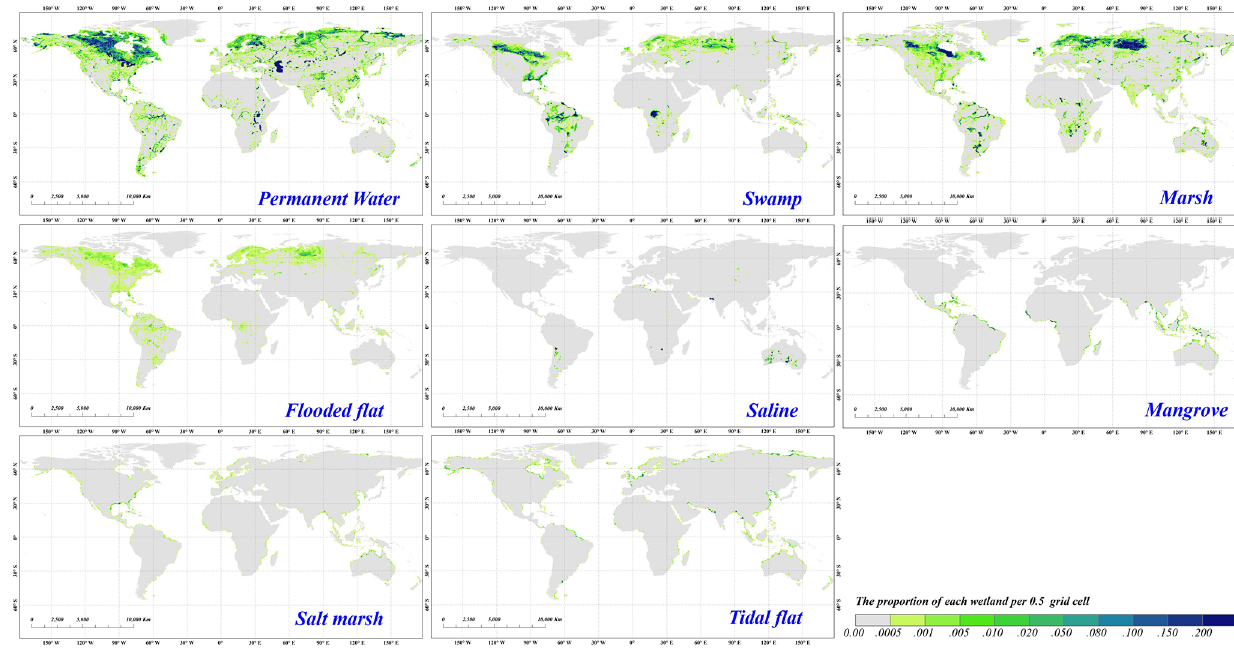
Figure 10. The spatial distributions of the eight wetland sub-categories after aggregating them to a resolution of 0 . 5 ◦ × 0 . 5 ◦ .